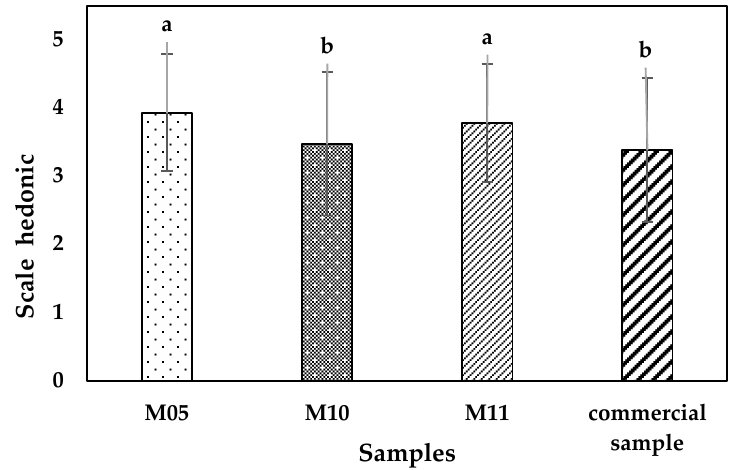
Figure 2. Comparison of means with the LSD Fisher Test ( p value < 0.05). a, b: means of the sam- ples.